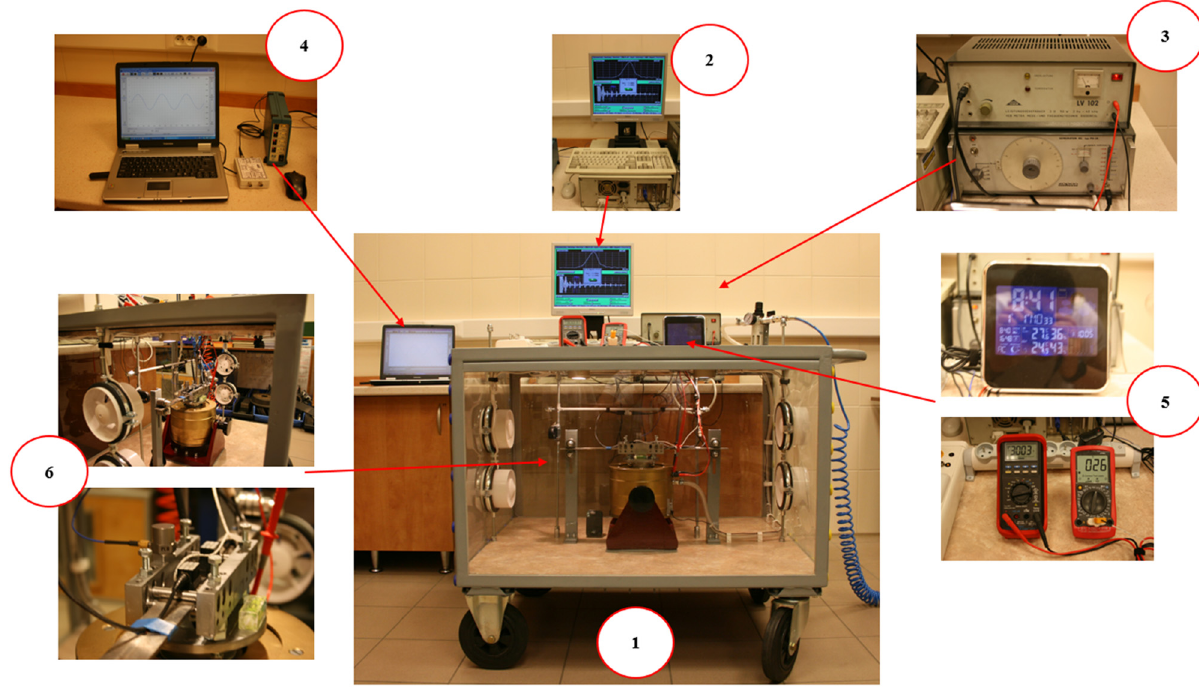
Figure 1: Stand for monitoring degradation of coating – substrate boundary with ultrasonic surface wave; 1 – view of the stand, 2 – ultrasonic fl aw detector, 3 – vibration inductor control, 4 – coating strip vibration control apparatus, 5 – instruments for monitoring ambient and inductor parameters and 6 – inductor with ultrasonic transducer mounted on the steel